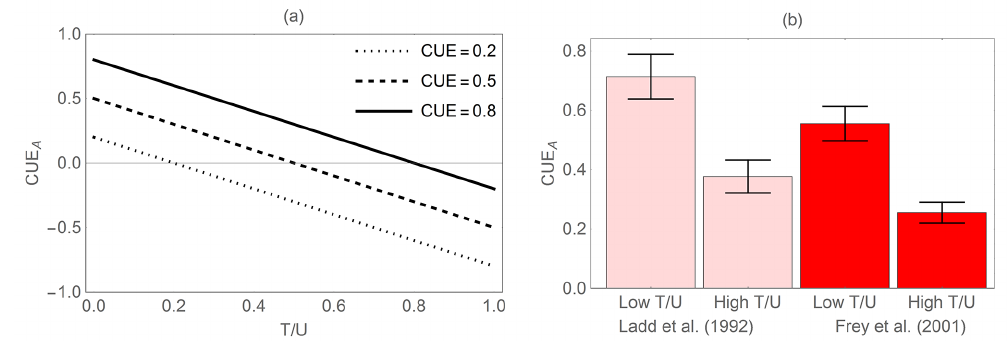
Figure 4. Effect of biomass turnover rate on the apparent C-use efficiency (CUE A ). (a) Theoretical relation between CUE A and the ratio of turnover rate to C uptake rate (Eq. 8, assuming negligible EX) for three values of the actual CUE. (b) Two examples of how high turnover rates cause a decrease in CUE A in empirical studies on soil microbial communities (Frey et al., 2001; Ladd et al., 1992). Lower turnover rates were caused by lower mortality in the first 3 days of incubation compared to day 112 (Ladd et al., 1992) or by lower grazing in the first 2 days of incubation compared to days 7–8 (Frey et al., 2001). Error bars indicate standard errors of the mean (variability is across three soil types in Ladd et al., 1992, and across replicates and soil types in Frey et al.,